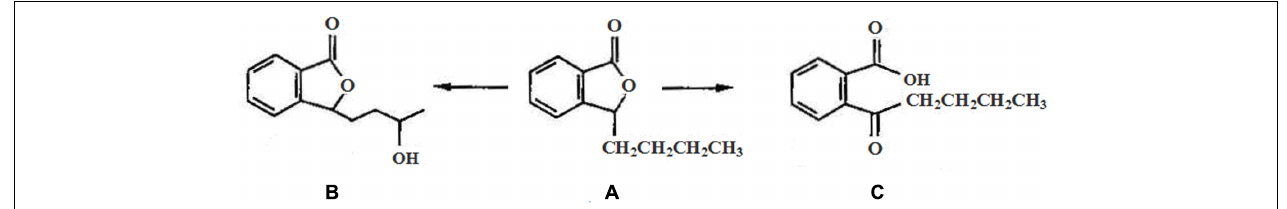
FIGURE 1 | The chemical structure of NBP and its main metabolites in vivo : (A) N -Butylphthalide, (B) hydroxylated metabolite of side-chain of NBP, and (C) oxidized metabolite of NBP after open loop of lactonic ring.